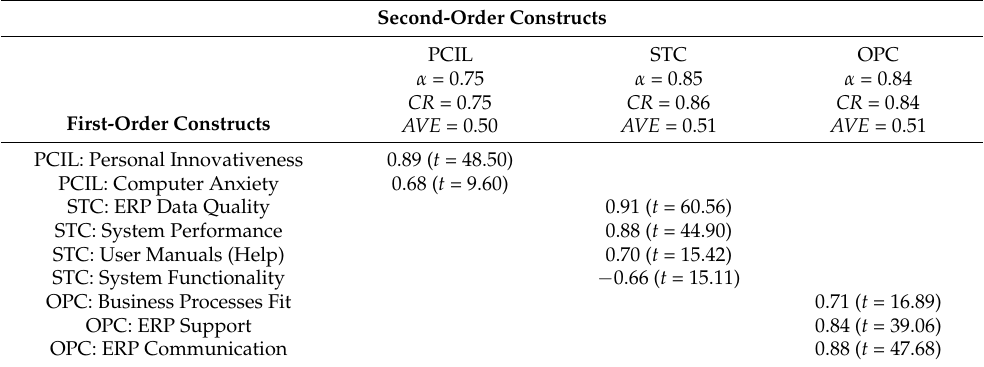
Table 6. Path coefficients—external constructs in the second-order